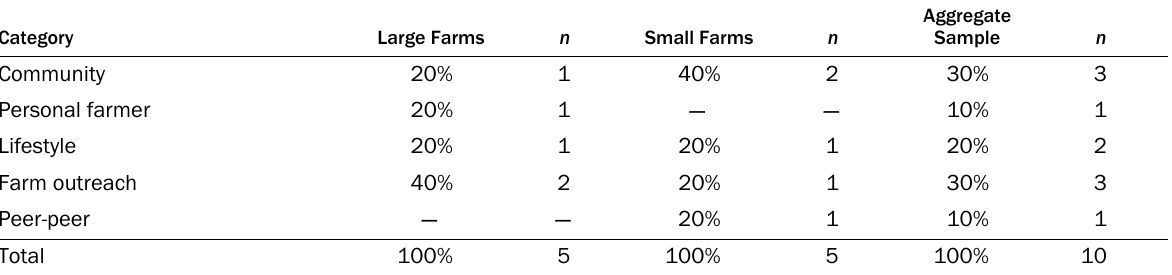
Table 8. What Aspects of This CSA Community Are Important to Farm-owners?